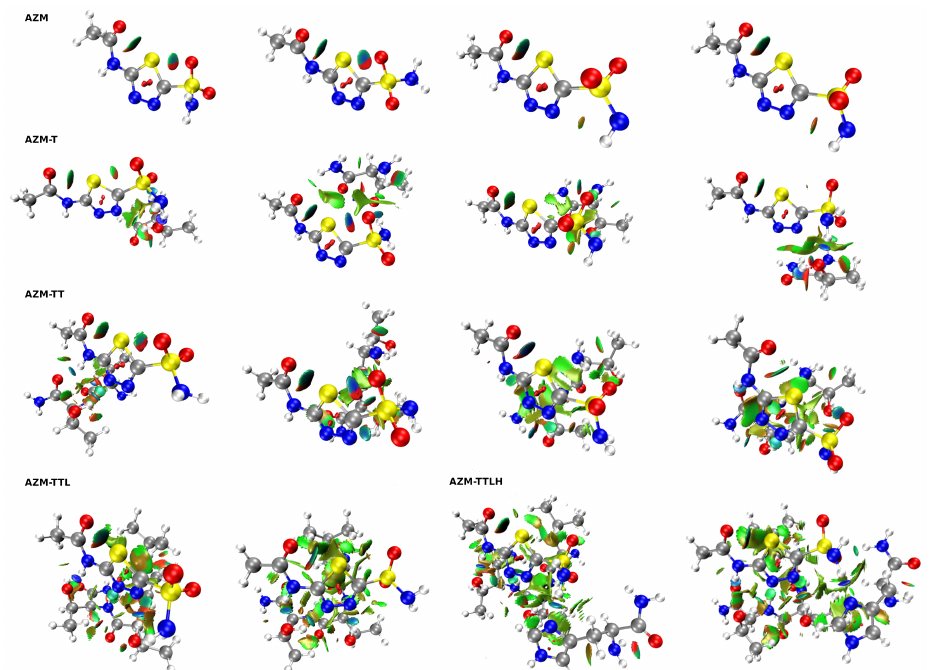
Figure 6. NCI diagrams of systems taken from the CPMD and optimized at the M06/aug-cc-pVDZ level of theory. Three types of geometries were taken from the course of the CPMD, namely: the structure with the smallest distance between S1 and O2A, the structure with the smallest distance for S1 and O2B, and the other structures, when the S1•••O2A and S1•••O2B distances were equal to each other. Diagrams of optimized structures are presented in the last column of every row (the exception is AZM-TTL, for which it is placed in the second column). In addition to optimized ones, in the case of AZM-TTL and AZM-TTLH, only geometries with values closest to the averaged distance were